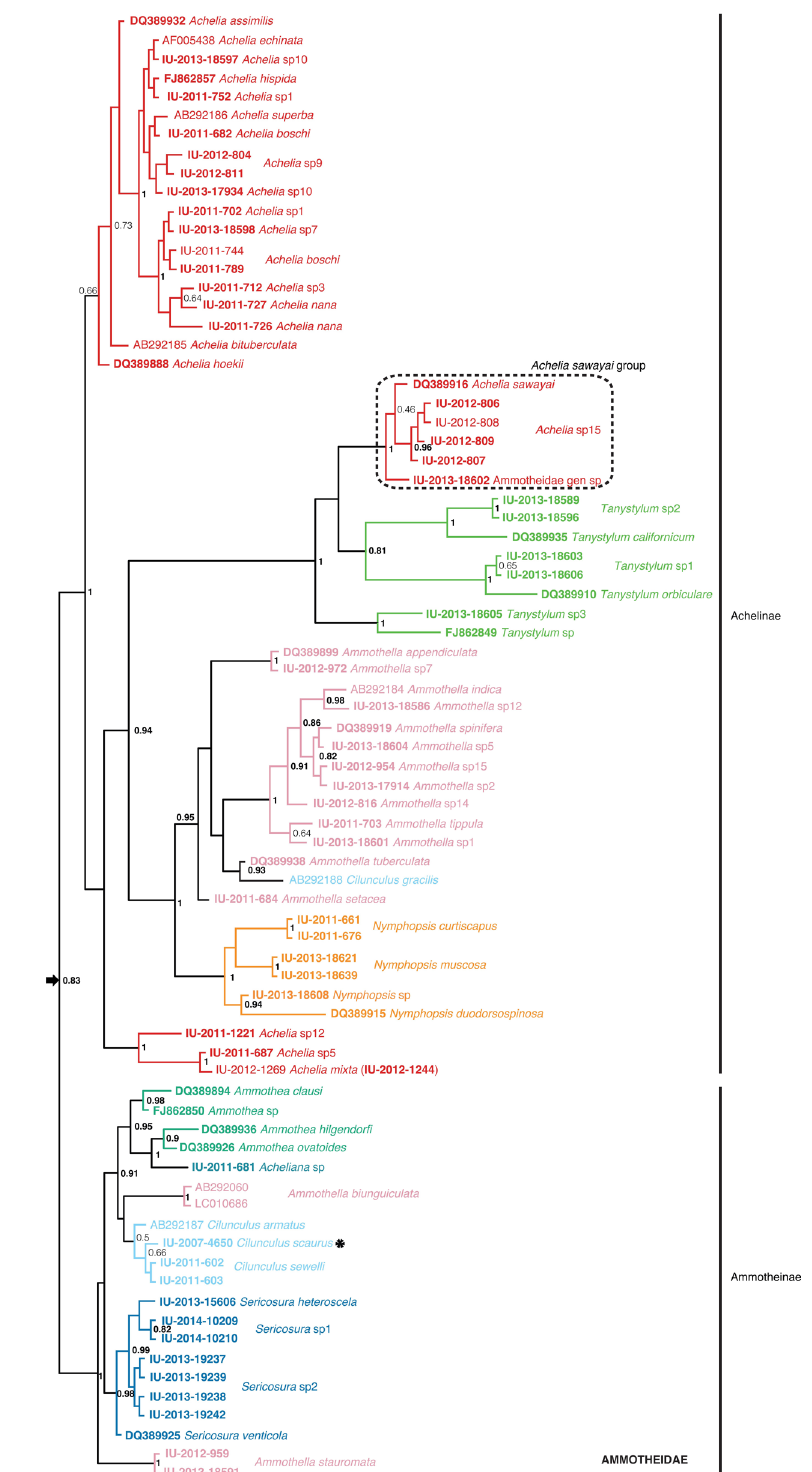
Fig. 4. Part 2, see Part 1 for